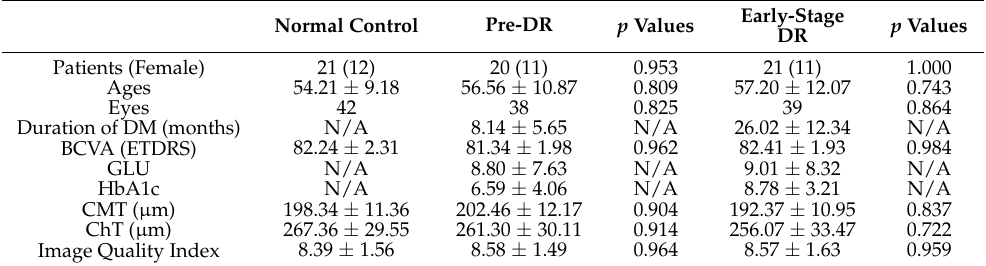
Table 2. Findings of optical coherence tomographical angiography in subjects with early-stage dia- betic retinopathy, DM without ophthalmoscopic signs of DR and non-diabetic control subjects. Table 1. Demographic characteristics and baseline features of DM patients and healthy controls.